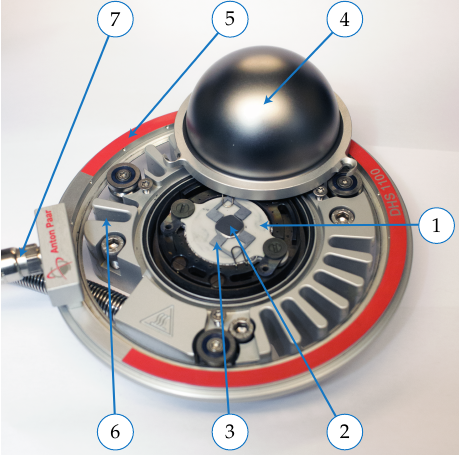
Figure 2. Image of the D OMED H OT S TAGE : (1) AlN base plate; (2) sample; (3) TiAl holders;